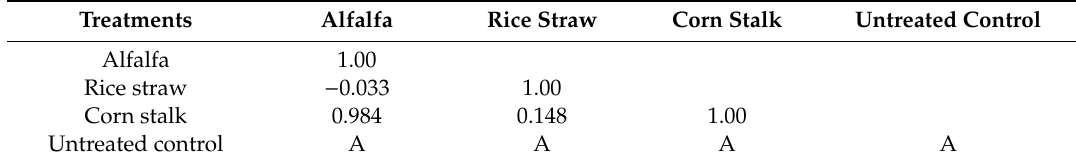
Table 3. In-vitro dry matter digestibility; Pearson correlation.